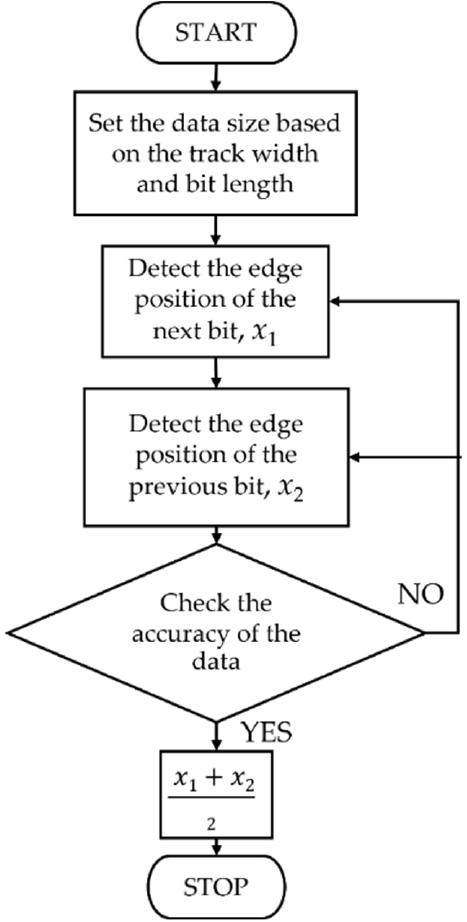
Figure 1. The zig-zag boundary procedure flow chart.